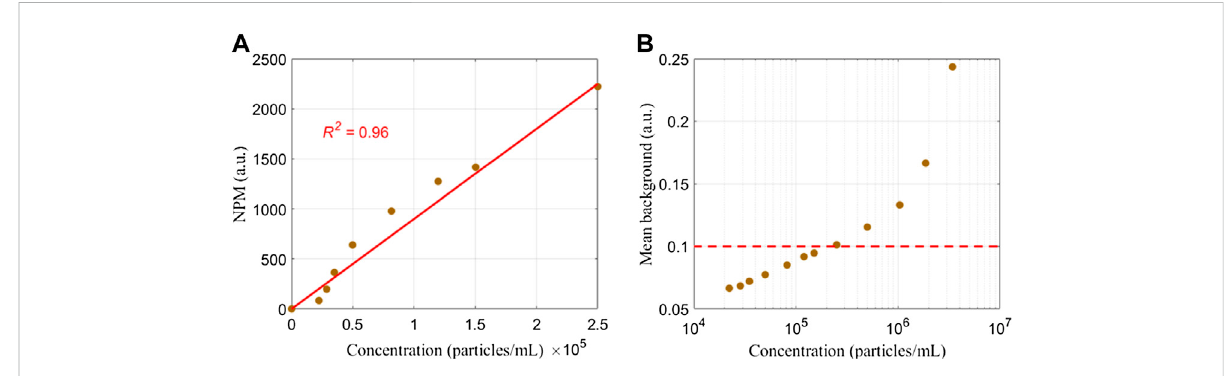
FIGURE 8 (A) NPM and (B) mean background with different concentrations using the new setup.